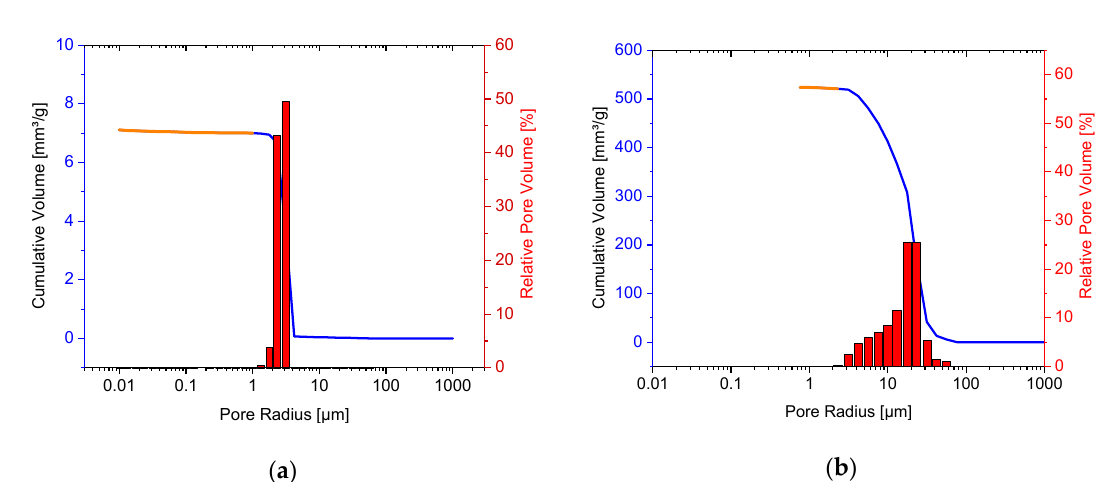
Figure 3. Pore size distribution ( a ): RMS ceramics and ( b ): Curasan ceramics .